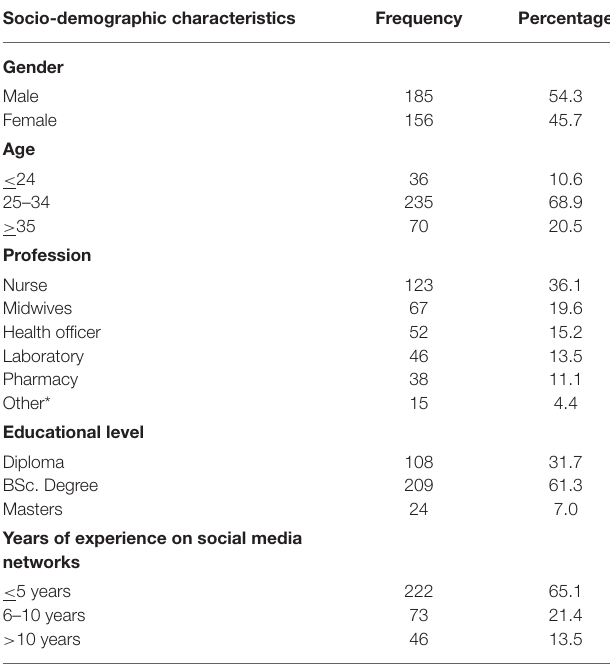
TABLE 1 | Socio-demographic characteristics and computer and internet access at Bahir Dar city health centers ( n =